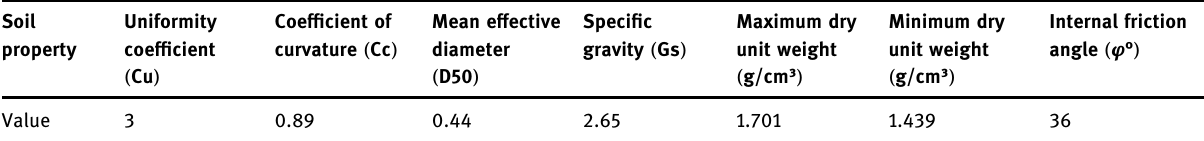
Table 1: Physical properties of soil Soil